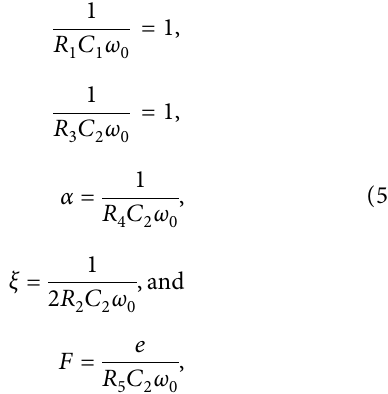
� 300 Ω , and TL 084 CN ≡ V 5